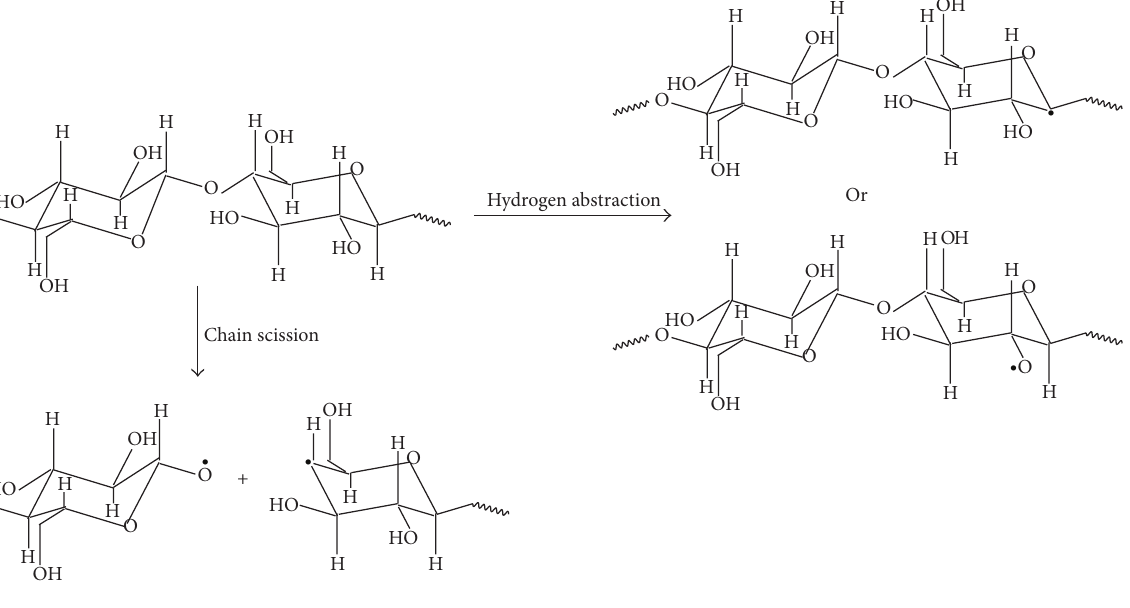
Scheme 2: Plasma action on cellulose